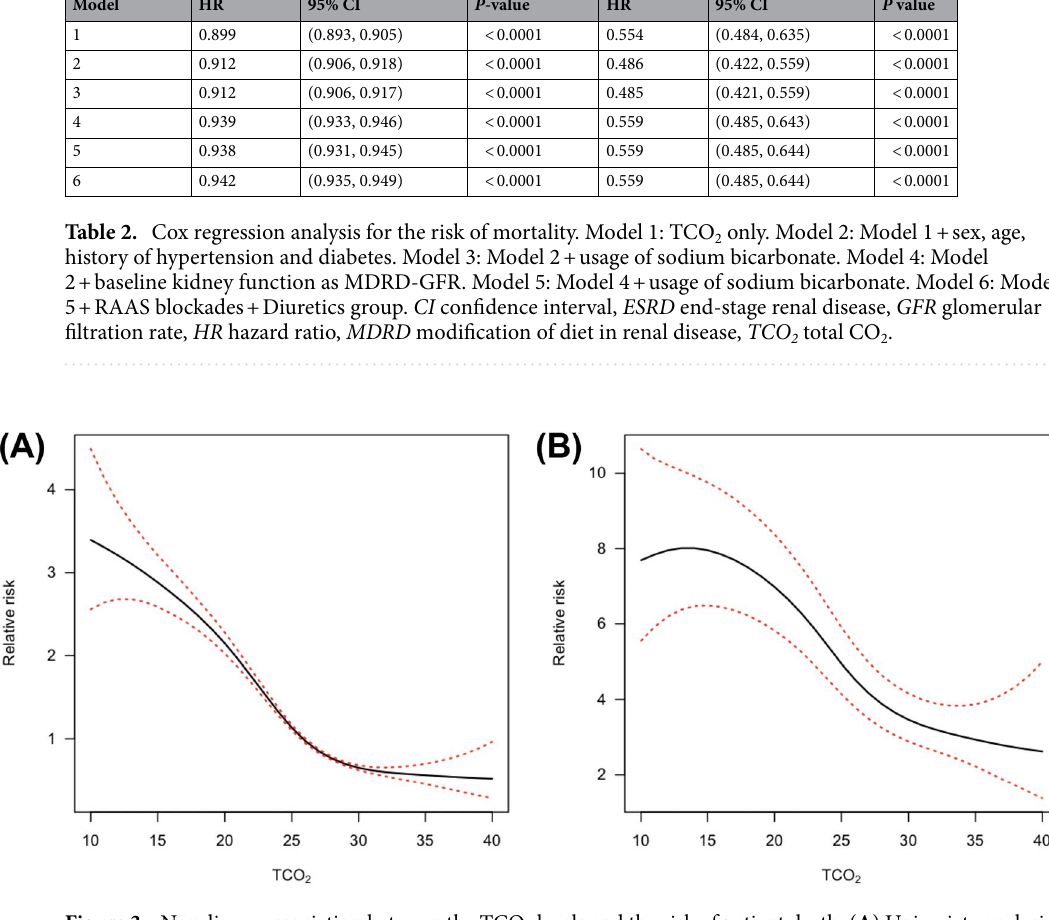
Figure 3. Non-linear association between the TCO 2 levels and the risk of patient death. ( A ) Univariate analysis ( B ) Multivariate analysis. These graphs were adjusted for TCO 2 level (as continuous variable), age, sex, history of hypertension and diabetes, baseline kidney function (as continuous variable using MDRD-eGFR), usage of sodium bicarbonate, RAAS blockades and diuretics.